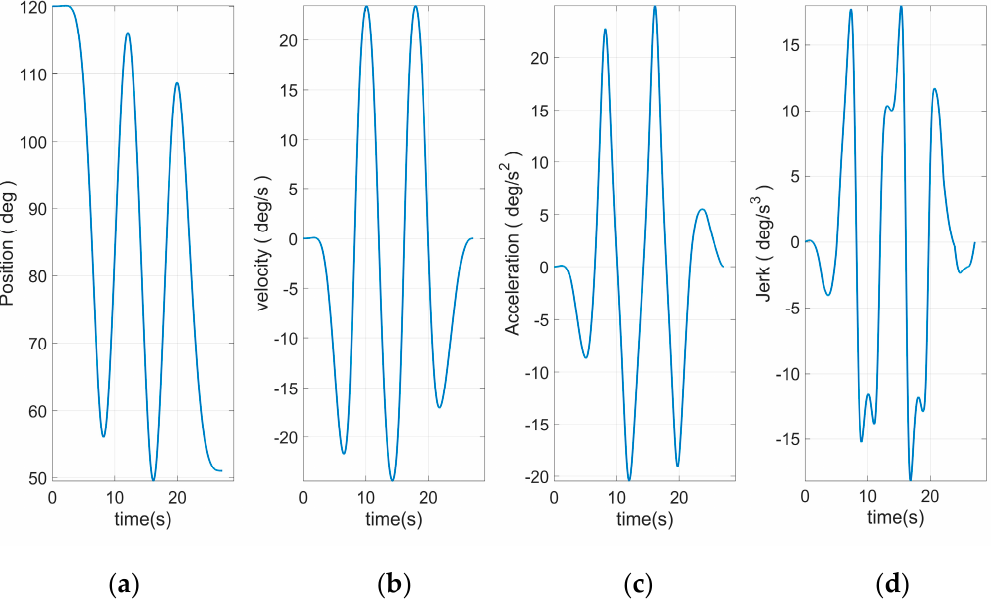
Figure 13. ( a ) Displacement of axis III over time. ( b ) Velocity of axis III over time. ( c ) Acceleration of axis III over time. ( d ) Jerk of axis III over time.